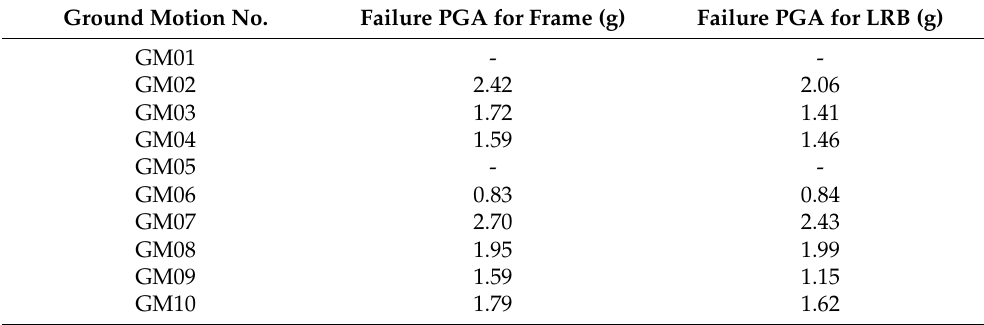
Table 2. Failure PGA for frame and LRB.